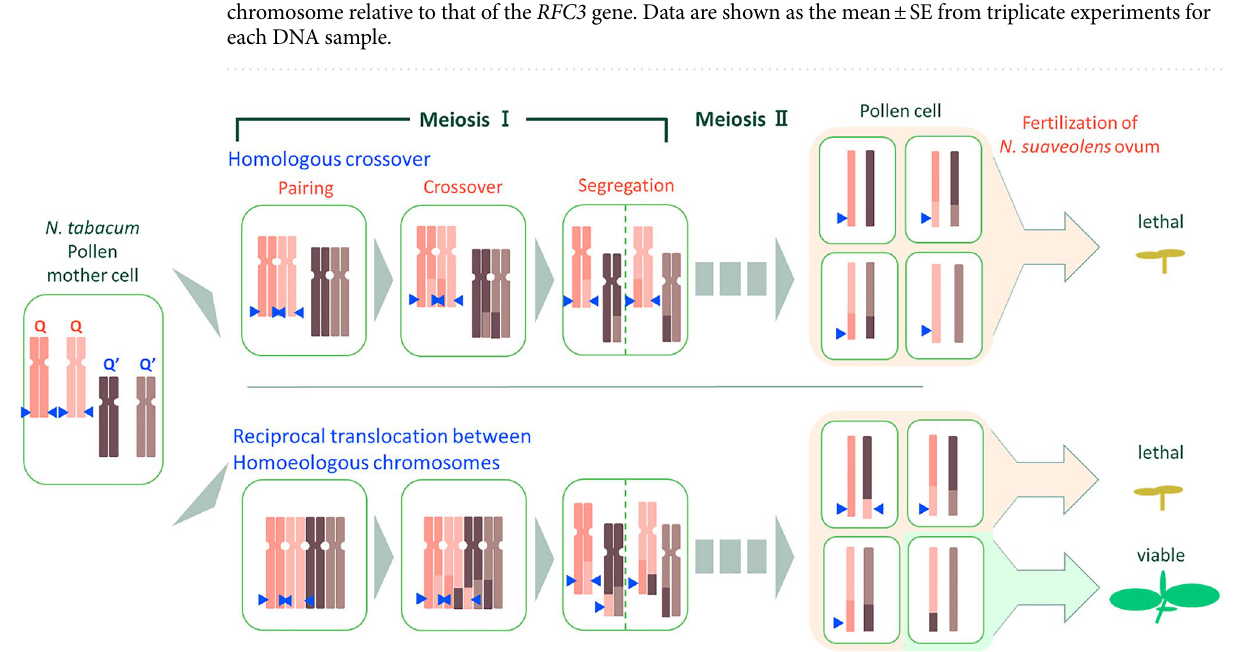
Figure 7. A proposed model for overcoming hybrid lethality by reciprocal translocation between homoeologous chromosomes in hybrid seedlings from the N. suaveolens × N. tabacum cross. Blue arrowhead indicates hybrid lethality-associated gene of N. tabacum